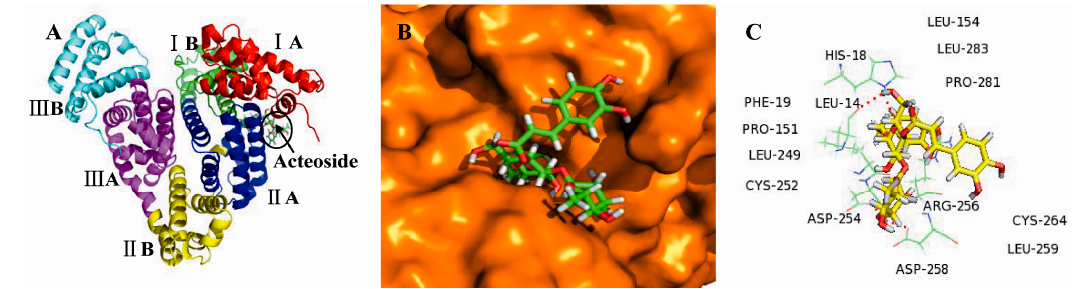
Figure 3. ( A ) The docking conformation of acteoside-BSA complex with the lowest energy conformation; the BSA and acteoside were represented in the cartoon as indicated; ( B ) Molecular docking model of acteoside partially located within sub-domain IIA of BSA; BSA and acteoside were represented by the orange sphere model and green stick model, respectively; ( C ) The surrounding hydrophobic amino acid residues within 6 Å and hydrogen bond interactions between acteoside and BSA; hydrogen bonds, amino acids, and acteoside were represented by red dashed lines, green lines, and yellow stick model, respectively.